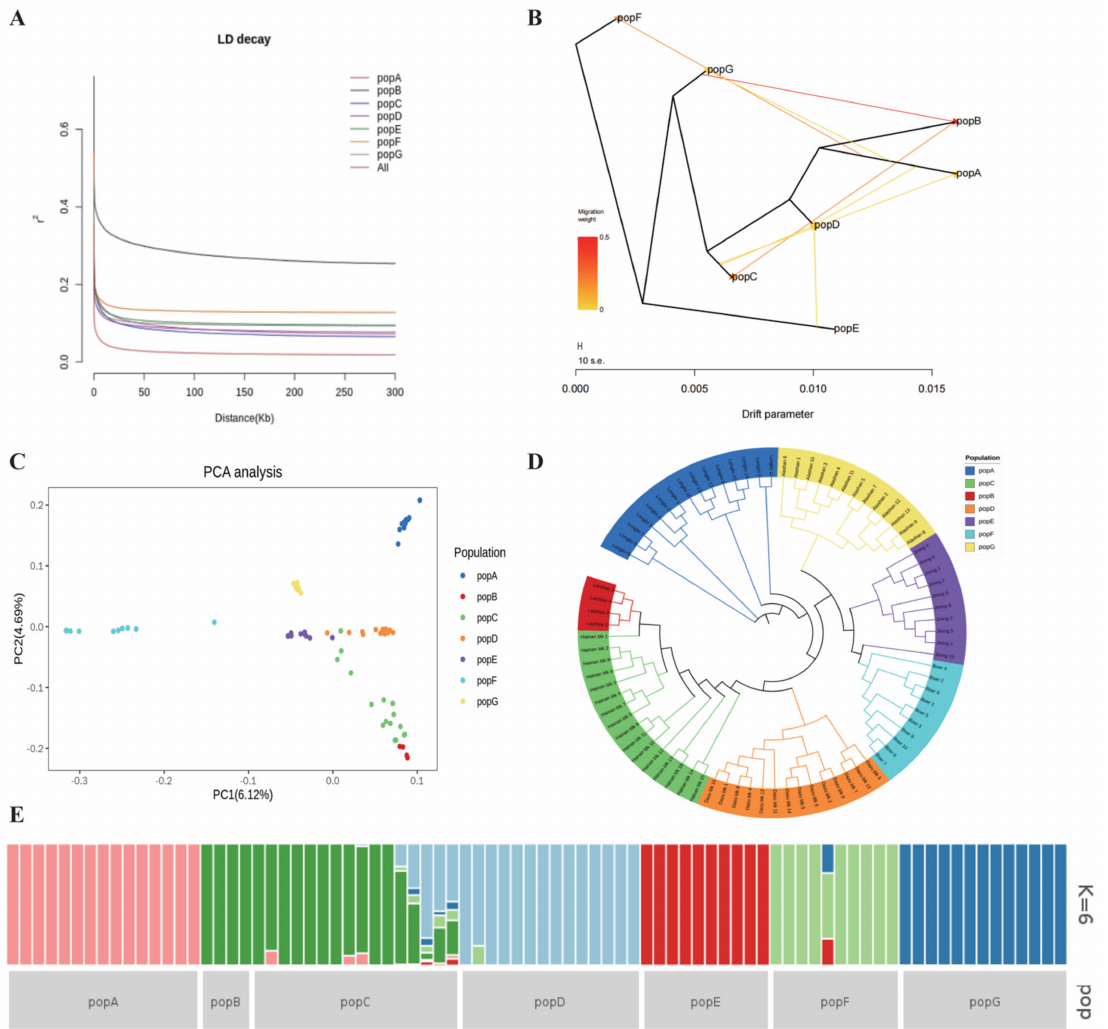
Figure 3. Genetic structure and characterization of 82 goats from 7 breeds. ( A ) LD analysis of each goat breed as well as all goats. ( B ) Pattern of population splits and mixture between the seven populations. The scale bar depicts 10 times the average standard error of the estimated entries in the sample covariance matrix. The migration edge from one lineage into another is colored according to the percent ancestry received from the donor population. ( C ) Principal components analysis (PCA) of seven goat breeds using their first two components. ( D ) Phylogenetic tree analysis of 82 individuals based on autosomal SNPs. ( E ) Ancestry proportions of 82 individuals using K = 6 clusters. popA (Longlin goat), popB (Leizhou goat), popC (Hainan Black goat), popD (Dazu Black goat), popE (Jining Gray goat), popF (Boer goat), and popG (Alashan Cashmere